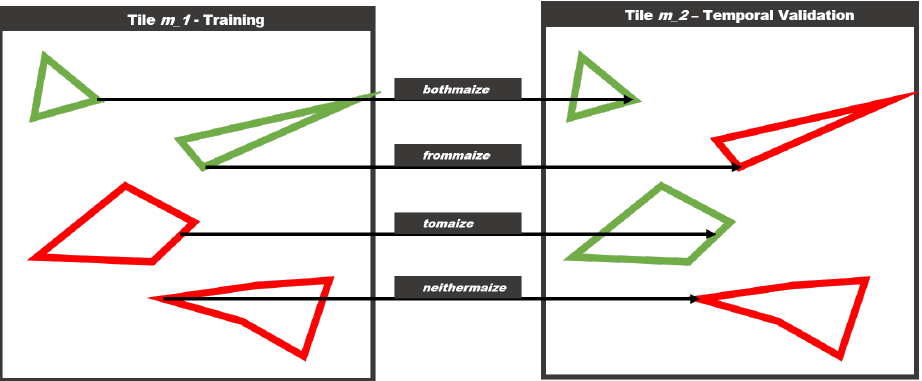
Figure 5. The figure describes the geometric scopes for the validation approach. Assuming the same geometry in a different year, there are four possible